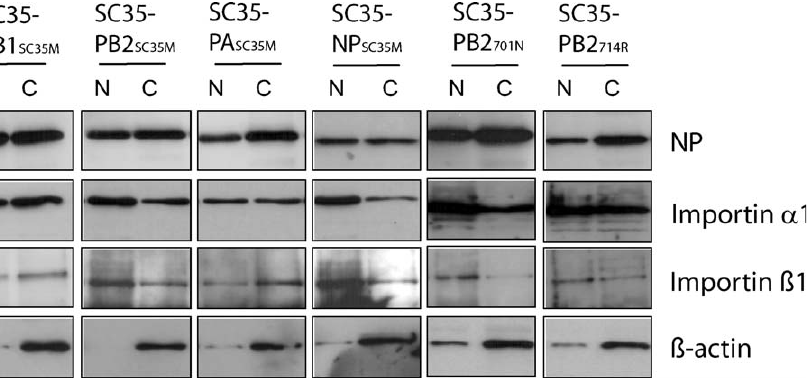
Figure 5. Distribution of Importin a 1 in Mammalian Cells 293T cells were infected at MOI 2 with SC35, SC35M, SC35-PB1 SC35M , SC35-PB2 SC35M , SC35-PA SC35M , SC35-NP SC35M , SC35-PB2 701N , and SC35-PB2 714R . Cells were harvested 6 h p.i. and separated into nuclear and cytoplasmic fractions. NP, importin a 1, importin ß1, and ß-actin were determined by Western blot analysis. doi:10.1371/journal.ppat.0040011.g005 PLoS Pathogens |